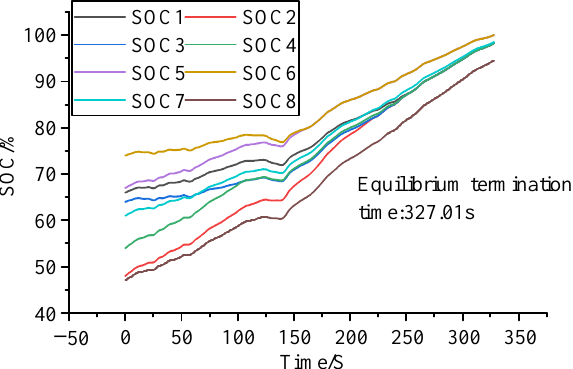
Figure 17. Lithium battery current change diagram. (Adjacent equalisation circuits and SOC difference-based equalisation strategies).